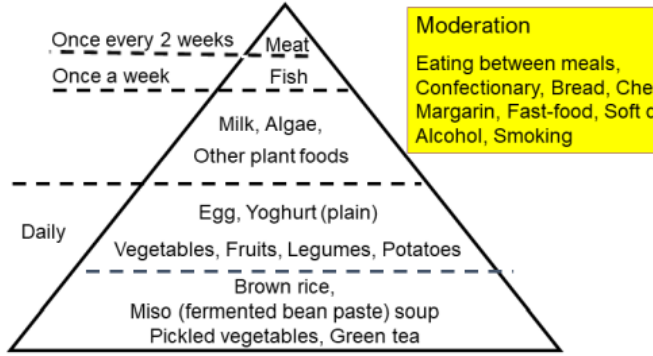
Figure 8. The semi-vegetarian-diet food guide pyramid.